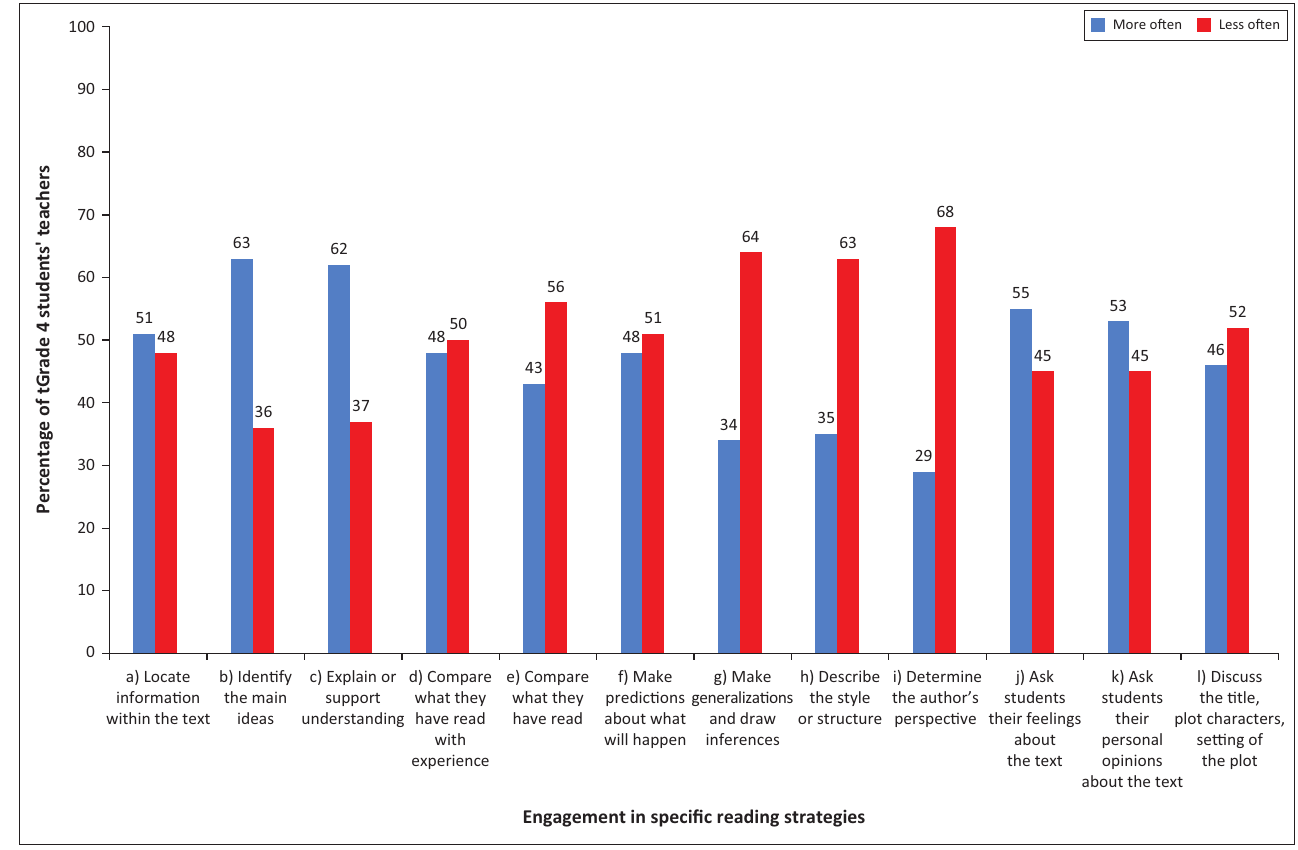
FIGURE 4: Teacher reports on engaging their students in specific reading comprehension